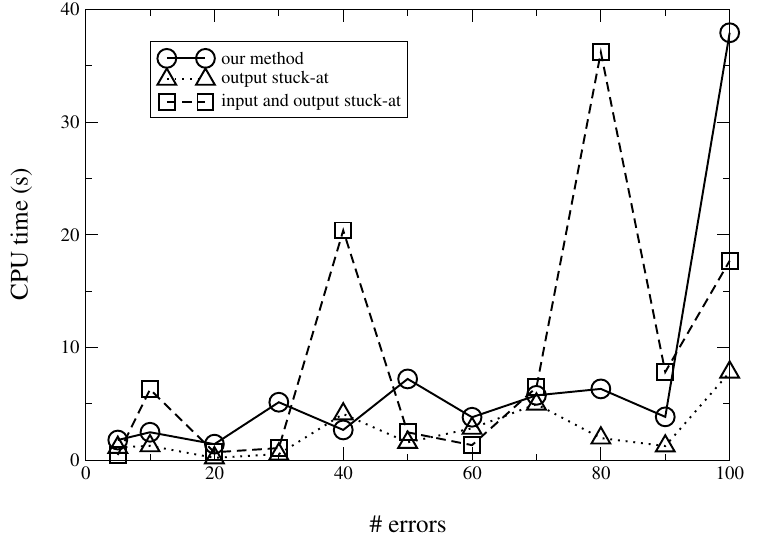
Figure 6. CPU time as a function of the minimum number of errors to be produced at POs for a gate-level implementation of the benchmark